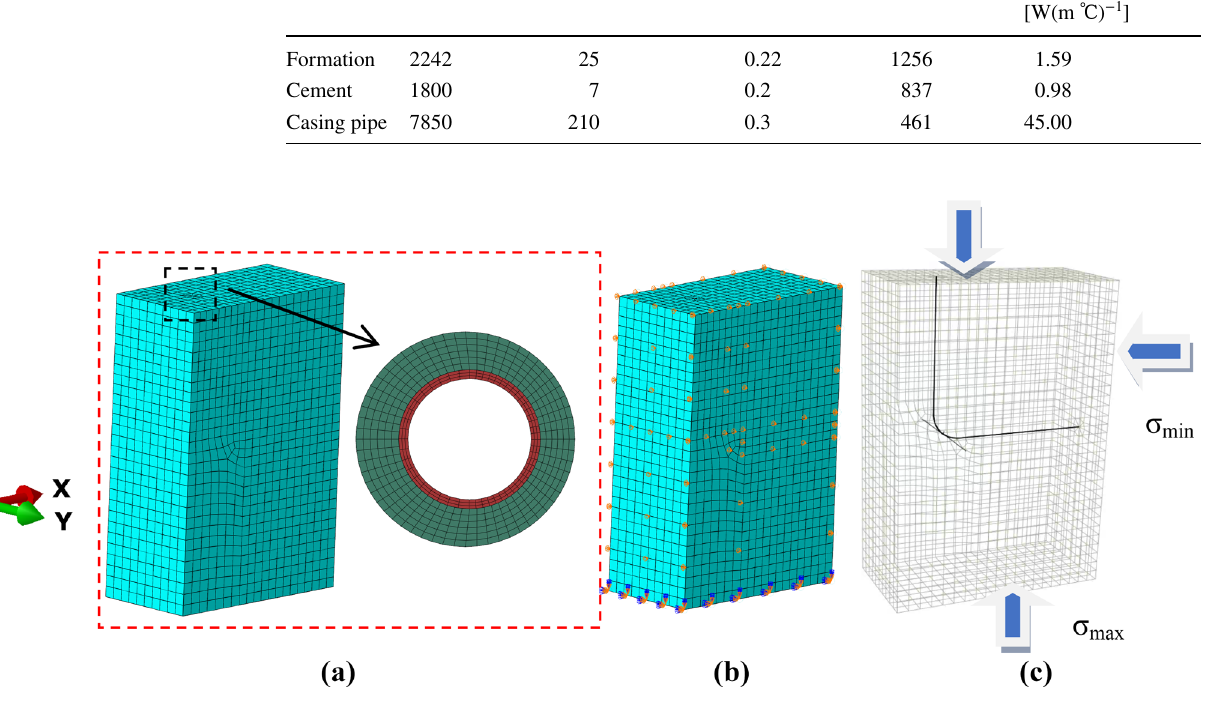
Table 2 Related parameters of formation, cement and casing